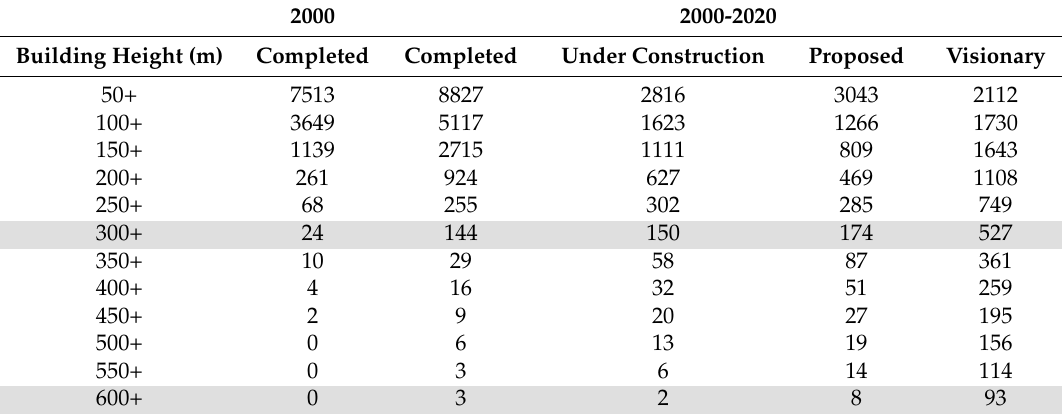
Table 1. Tall buildings in 2000 and 2020. In recent years, we have been building more tall buildings with greater heights. In addition, buildings “under construction,” “proposed,” or “visionary” categories feature greater heights. Shaded rows highlight the supertall and megatall